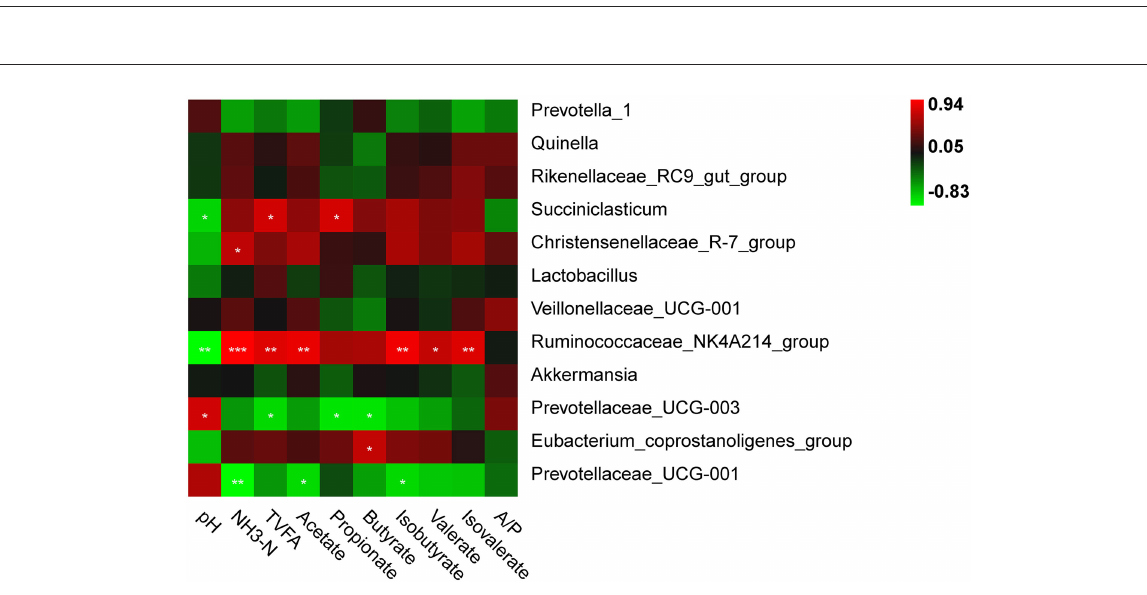
growth and proliferation, immune function, and integrity and barrier function of the rumen epithelium, including ECM-receptor interactions, focal adhesion, PI3K-Akt signaling, complement and coagulation cascades, and regulation of the actin cytoskeleton (Figure 5D).